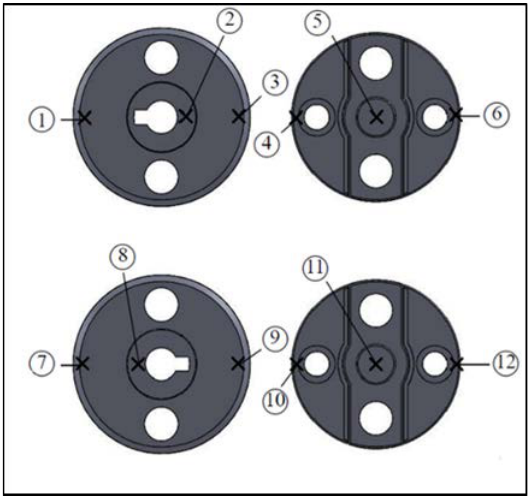
Figure 3. Schematic of Locations of Measurement Points for Car Lock Part.